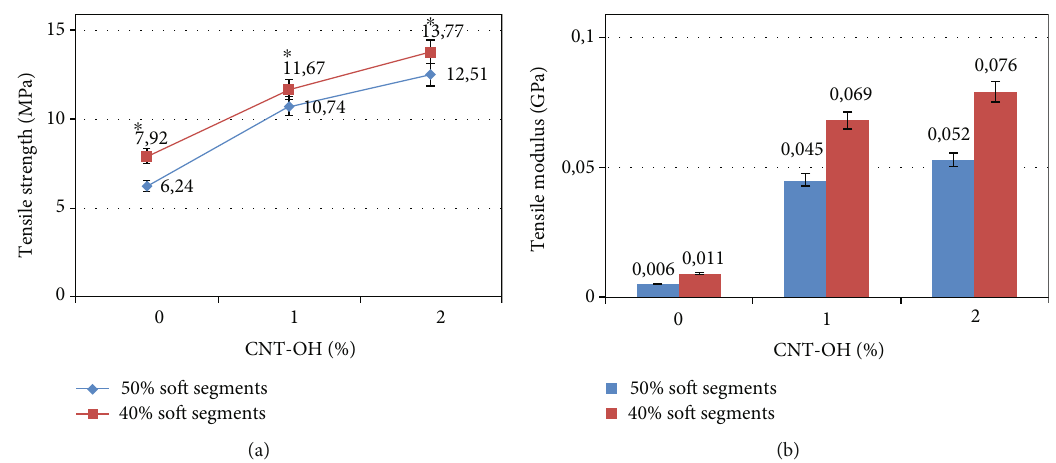
Figure 3: Tensile strength (a) and tensile modulus (b) of samples in function of CNT-OH content ( ∗ ) denotes statistically signi fi cant di ff erence between the samples di ff ering in the content of soft segments ( p < 0 : 05 ).